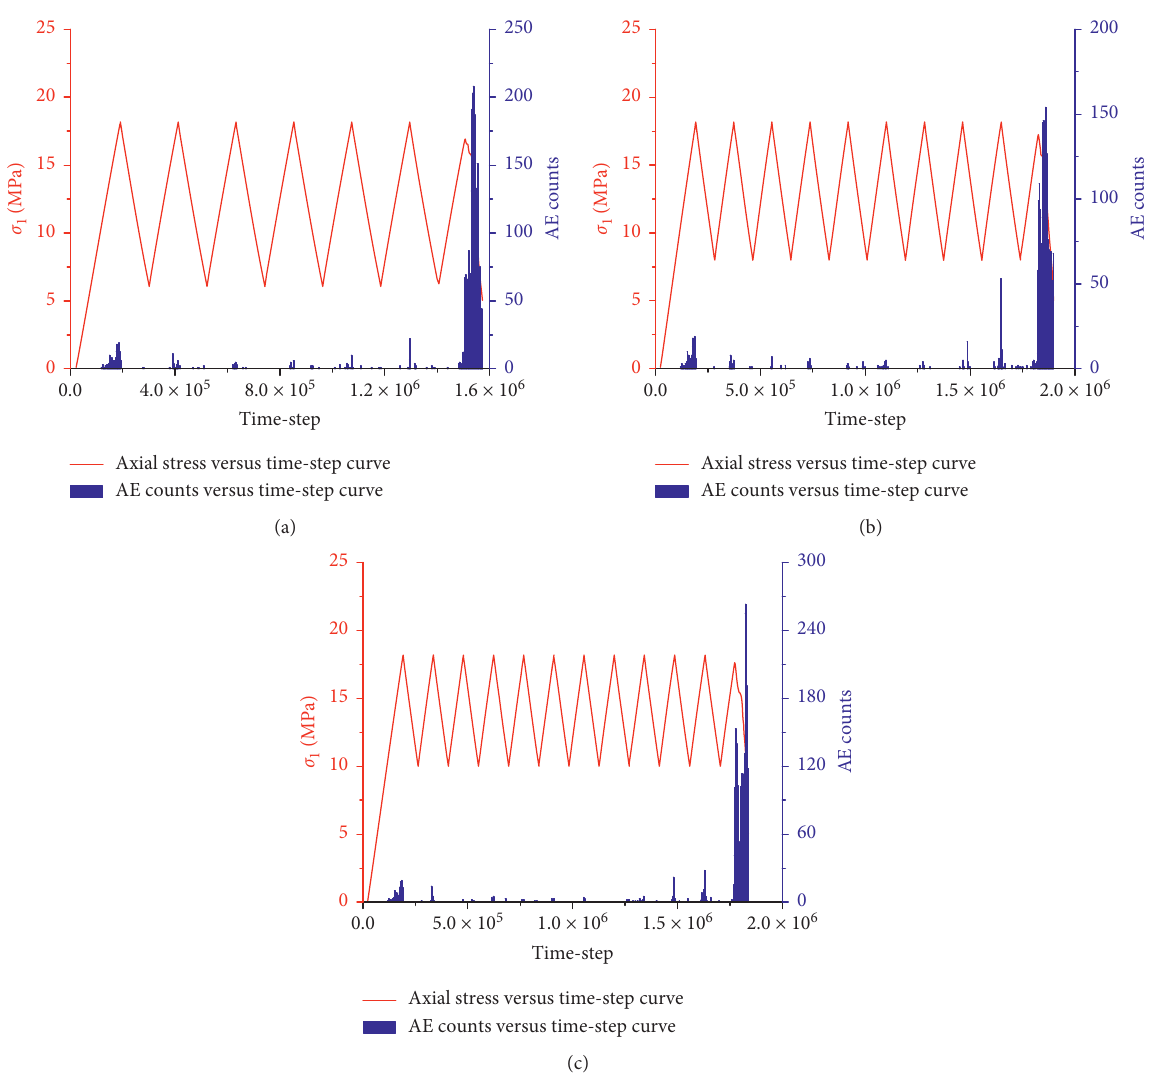
Figure 13: AE counts and axial stress versus time-step curves under different valley stresses: (a) 6 ∼ 18.18MPa, (b) 8 ∼ 18.18MPa, and (c) 10 ∼ 18.18MPa.